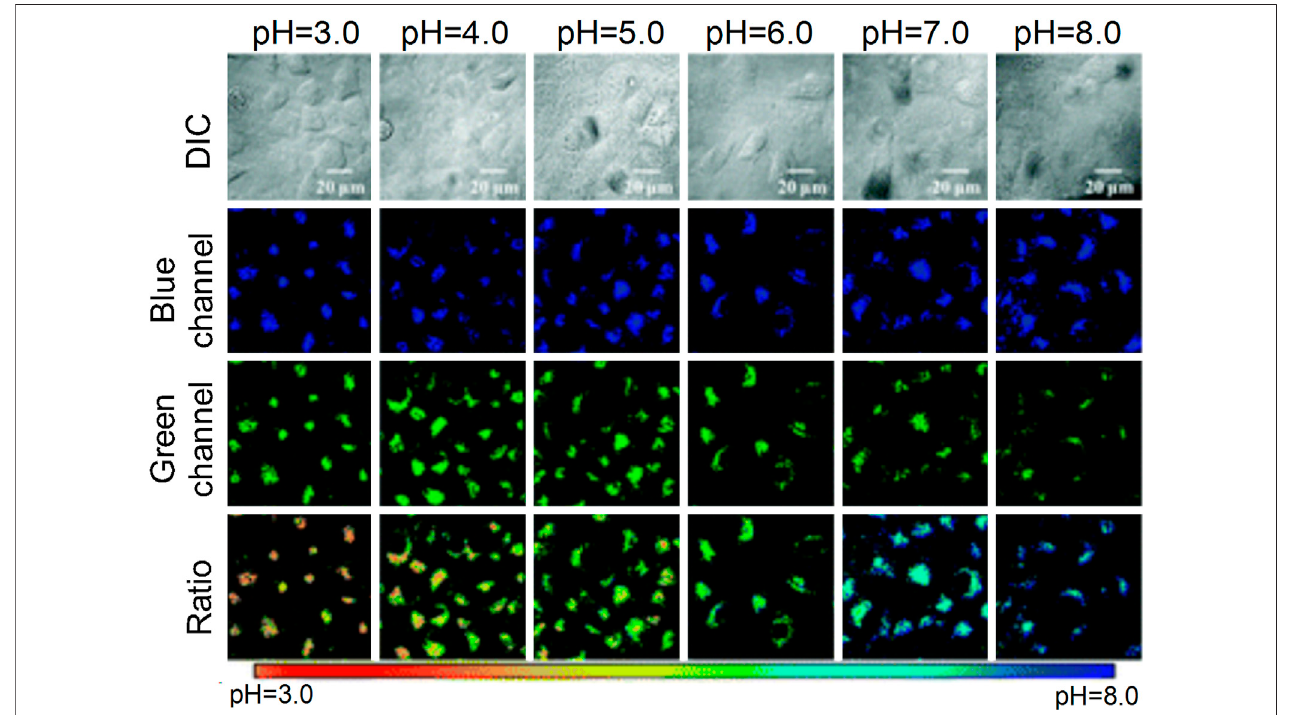
FIGURE 13 | The action mechanism of Lyso-MPCB to lysosome pH value (Peng et al., 2019)